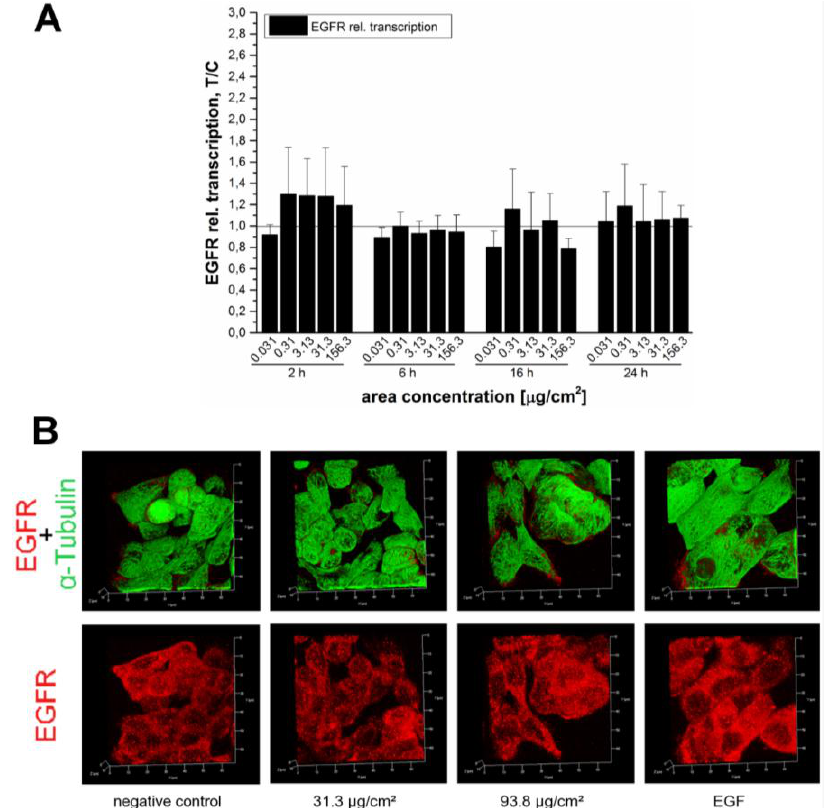
Figure 9. Investigation of the molecular mechanisms influencing the EGF receptor at the cellular level by analysis of its relative mRNA transcription rates and its localization in GXF251L cells. ( A ) Relative gene transcription rates of the EGFR after incubation with 12 nm SiO 2 NPs for 2 h, 6 h, 16 h and 24 h. The depicted bars represent the relative transcription rates in relation to the negative control (solid line) after normalization to β -actin and GAPDH expression (T/C [%]) ( n ≥ 3); ( B ) 3D reconstruction of the appearance of the EGFR localization (red) and tubulin cytoskeleton (green) after immunocytochemical analysis. Represented are the results of the negative control, the incubation with 31.3 µ g/cm 2 and with 93.8 µ g/cm 2 of 12 nm SiO 2 NPs after 45 min of incubation and EGF stimulation as positive control. Scale bar distances are expressed in 10 µm.